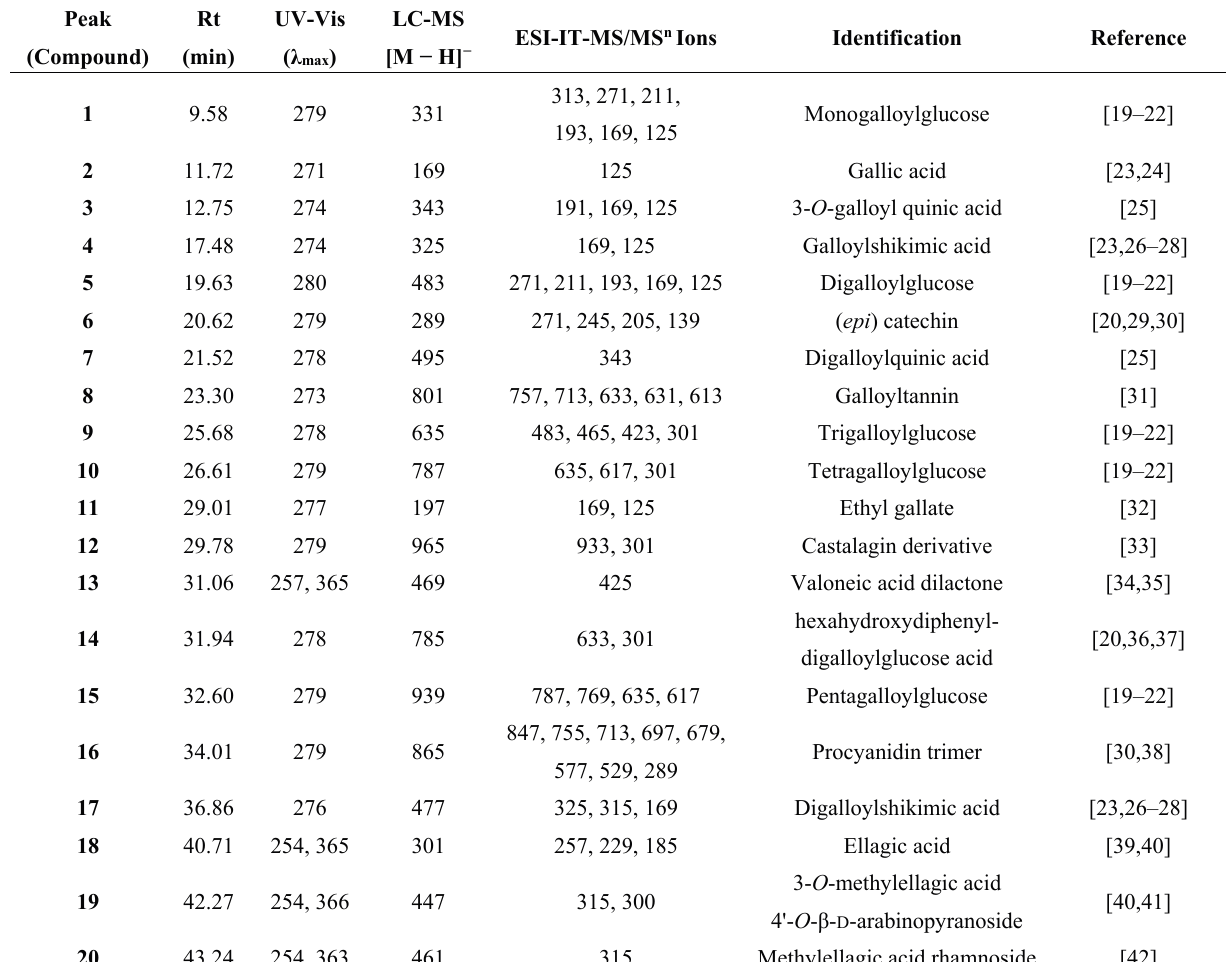
Table 1. HPLC/ESI-IT-MS data of the compounds detected in the ethanol extract from the stem bark of C . ferrea (negative